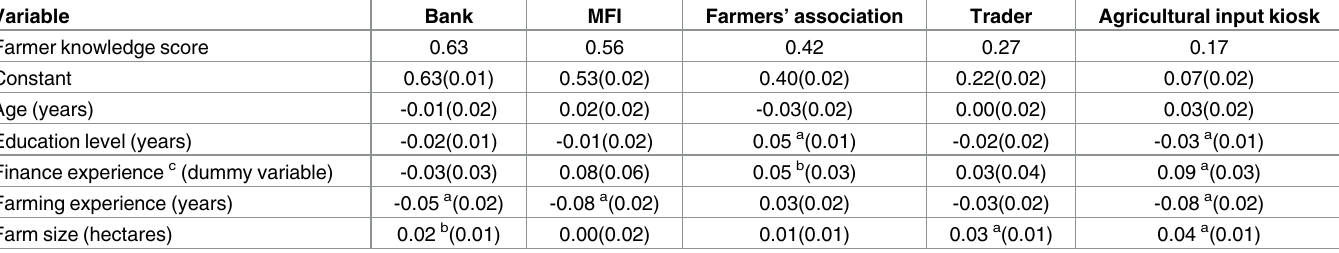
Table 4. Mean farmerknowledge scores and coefficients from the censored regression of knowledge scores on the influencing factors (n = 434), standard errors in parentheses.